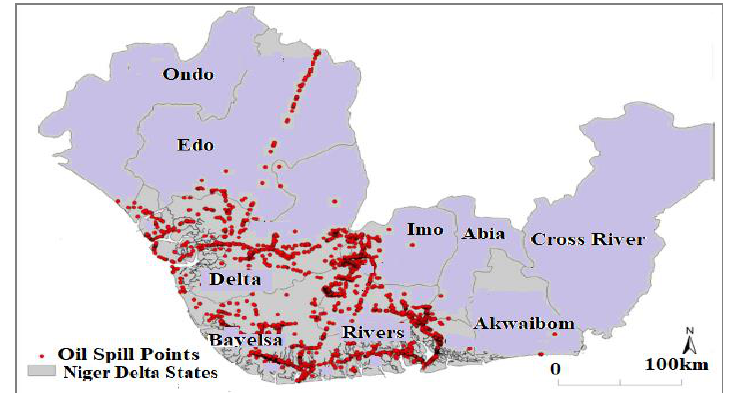
Figure 2. Spatial distribution of pipeline oil spills in the Niger Delta from 2007 to